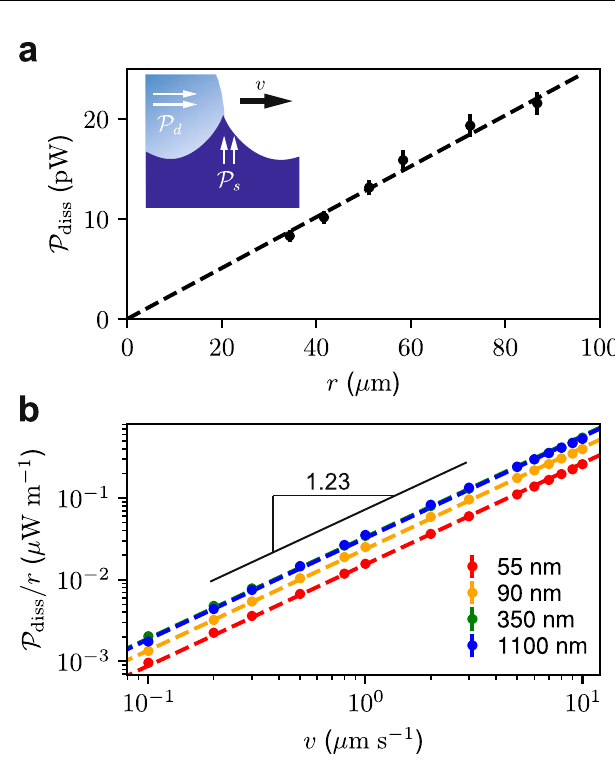
Fig.2|Forceandperimetermeasurements.a Sideviewofadropletmovingwith aspeed of v =1 μ ms − 1 .In the imageshown, thesubstrate is moving to the left, so that the droplet motion is towards the right with respect to the substrate. The droplet equilibrium contact angle is~80 ∘ . The bottom half of the image is the re fl ection of the droplet and pipette in the substrate (re fl ection plane indicated within drop). The dashed line is the location where the force is obtained from